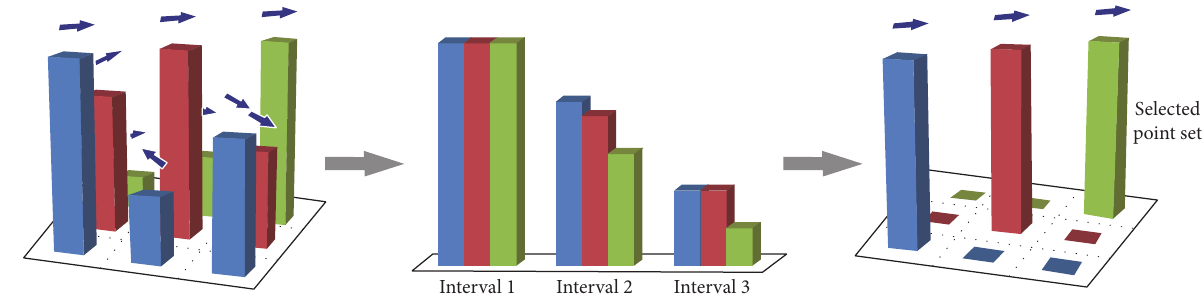
Figure 5: Illustration of pseudo-ordering method using a 9-pixel